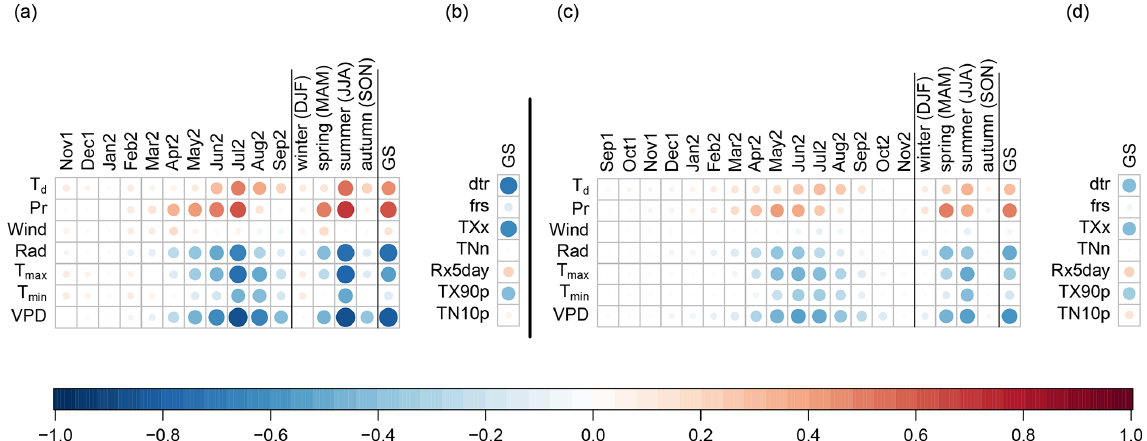
Figure 3. Linear correlations between potential meteorological predictors and annual yield. (a) Correlation between the monthly, seasonal and growing season (GS) averages of the meteorological variables and annual yield for a grid point in France (47.7 ◦ N, 1.1 ◦ E). (b) Correlation of the climate extreme indicators (Table 1) and annual yield for the same grid point. (c, d) Average of the same correlations across all Northern Hemisphere grid points. Note that panel (a) shows the correlation for all months included in the growing season of the grid point in France, while panel (c) shows the average correlation for a given month computed over all grid points containing this month in their growing